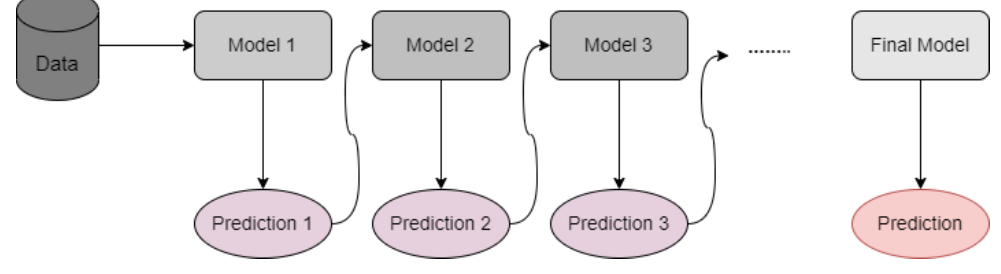
Figure 3. Gradient